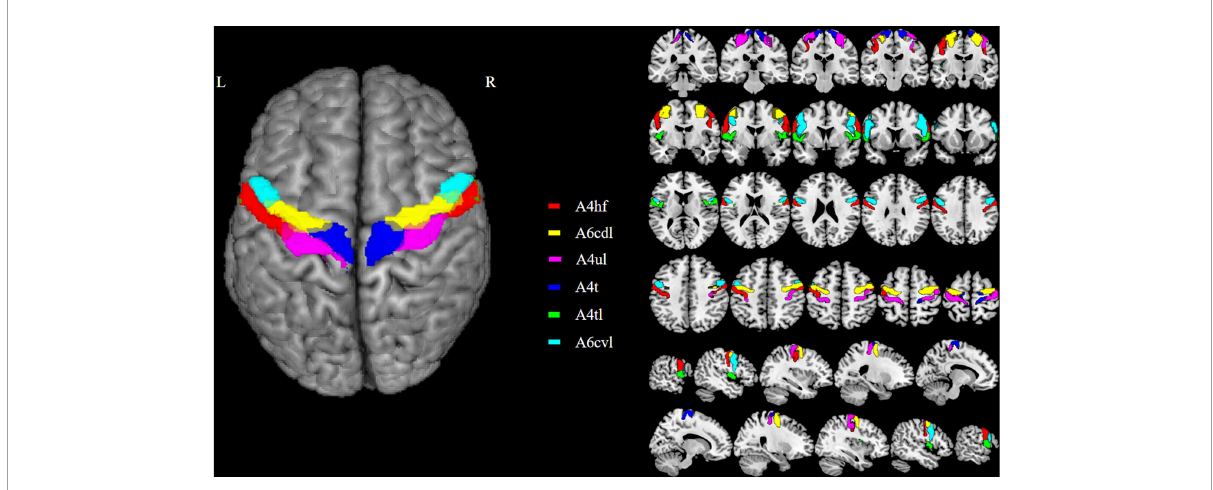
FIGURE1 The top viewport displays the subregions of M1. There are 12 M1 subregions in the Human Brainnetome Atlas, including bilateral A4hf, A6cdl, A4ul, A4t, A4tl, and A6cvl. M1, primary motor cortex.